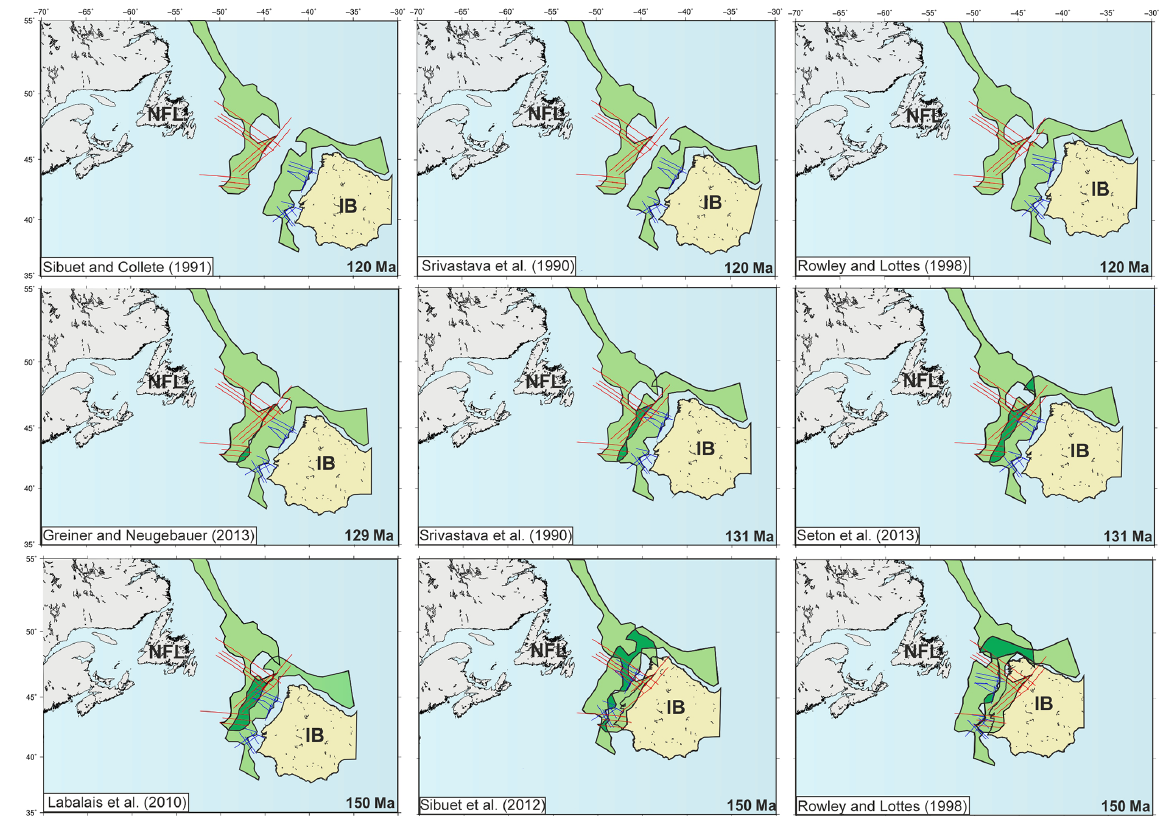
Figure 8. Reconstructions of the COTZ envelope from Eagles et al. (2015) at (a) Aptian, (b) Barremian, and (c) Tithonian (“full-fit”) times, showing the range of virtual conjugates generated by alternative rotation schemes. Blue and red lines are the TGS Iberian and Newfoundland datasets, respectively. NFL: Newfoundland; IB: